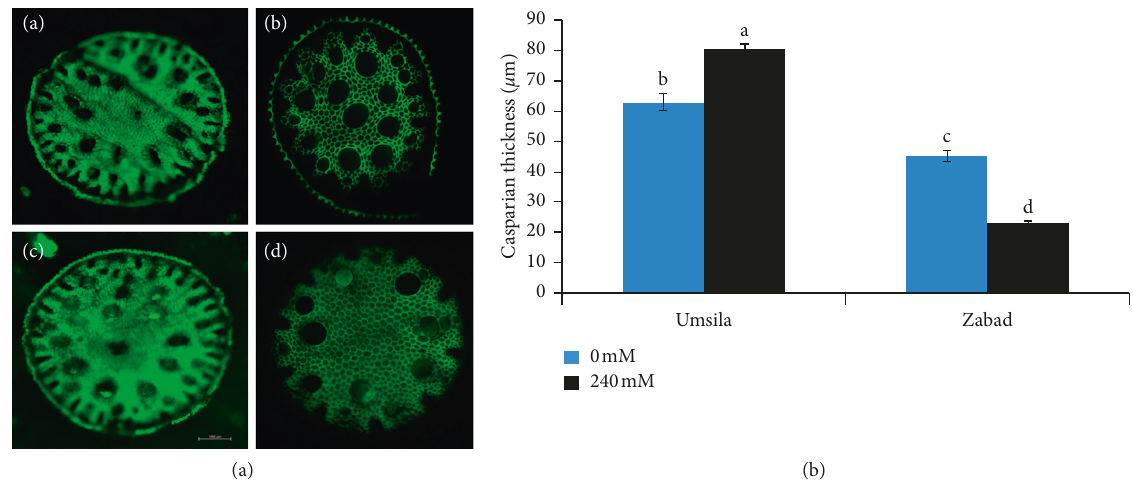
Figure 10: (a) Staining of Casparian strips of the date palm roots. Casparian strips staining of Umsila roots grown under control (a) and salinity conditions (b), and Zabad roots grown under control (c) and salinity conditions (d). (b) Bars represent mean of the Casparian strip thickness measured under the fluorescent microscope ± SE ( n � 3). Bars with the same letter are not significant at p ≤ 0 . Soluble sugars act as osmolytes to maintain homeostasis in response to adverse environmental stresses [17, 65, 66].